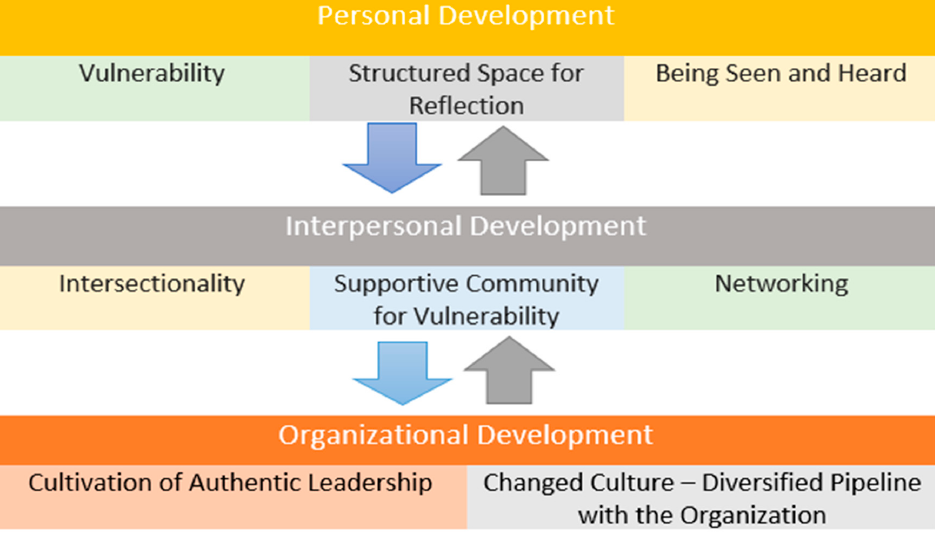
Figure 1. Women’s Leadership Levels and Themes (Final Version).